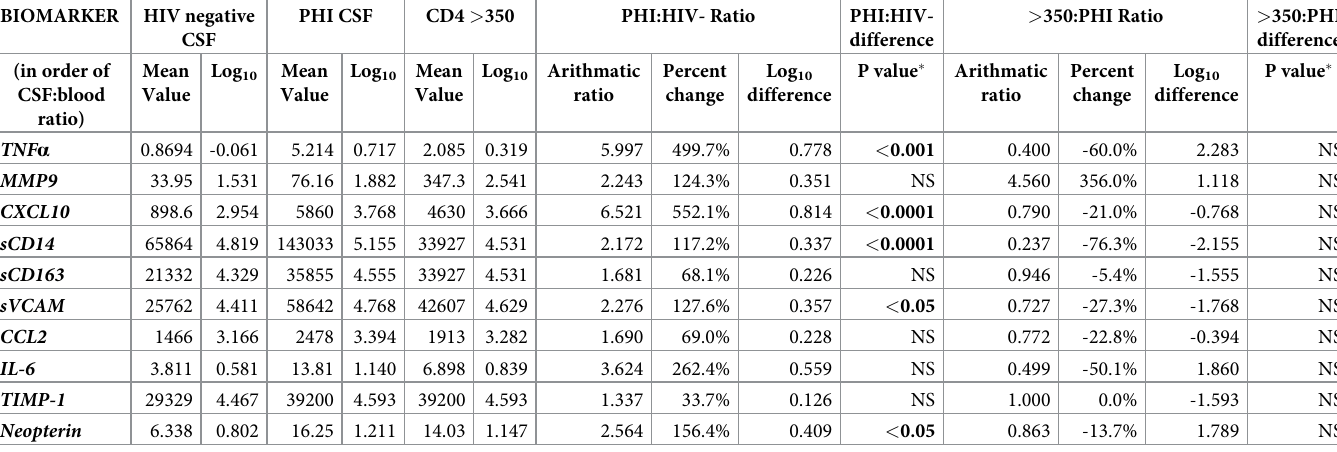
Neopterin � P values from Kruskal-Wallis test across three groups (HIV negative, PHI, and CD4 > 350) and Dunn’s multiple comparison test.